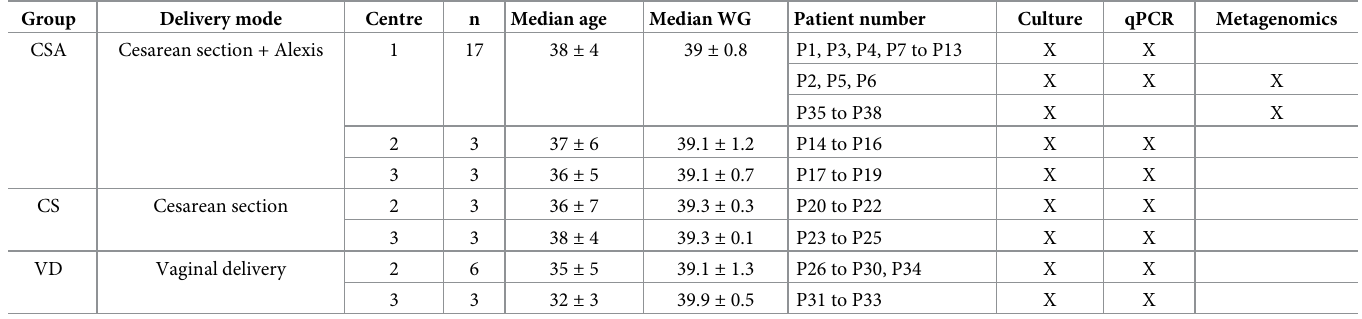
Table 1. Main characteristics of the